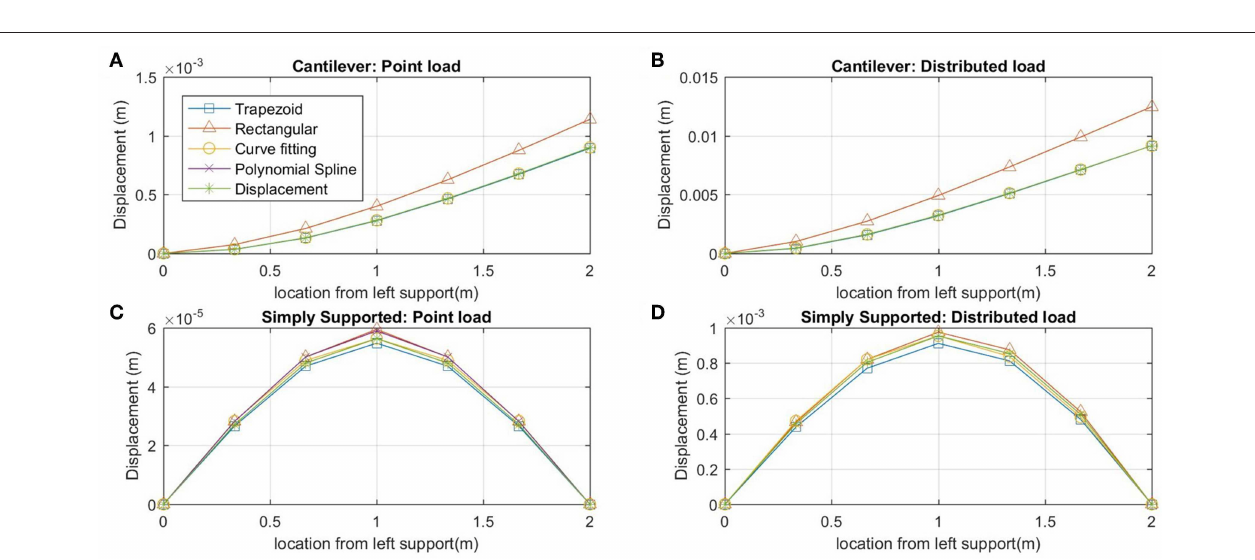
RMS error substantially. With only 5 sensor locations, both